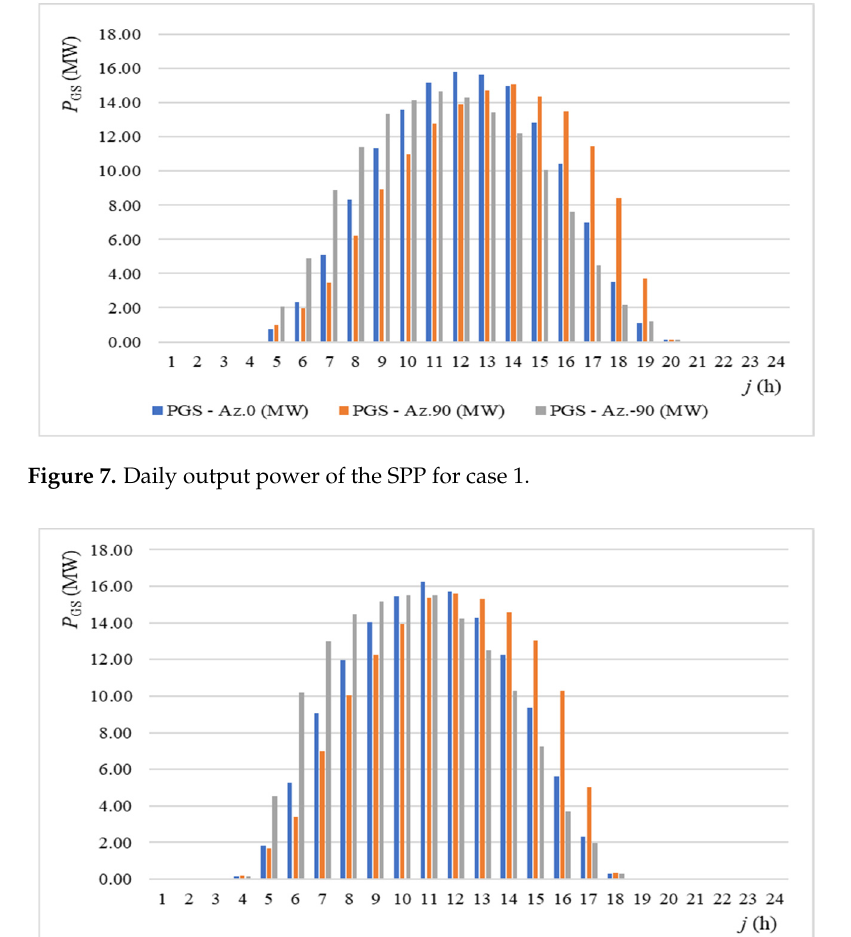
16 of 26 Figure 6. HUPX’s electricity price diagram for the chosen optimization period (09.06.2021). Table 6. Data for case 1: Gaag, Netherlands. Sub-Case